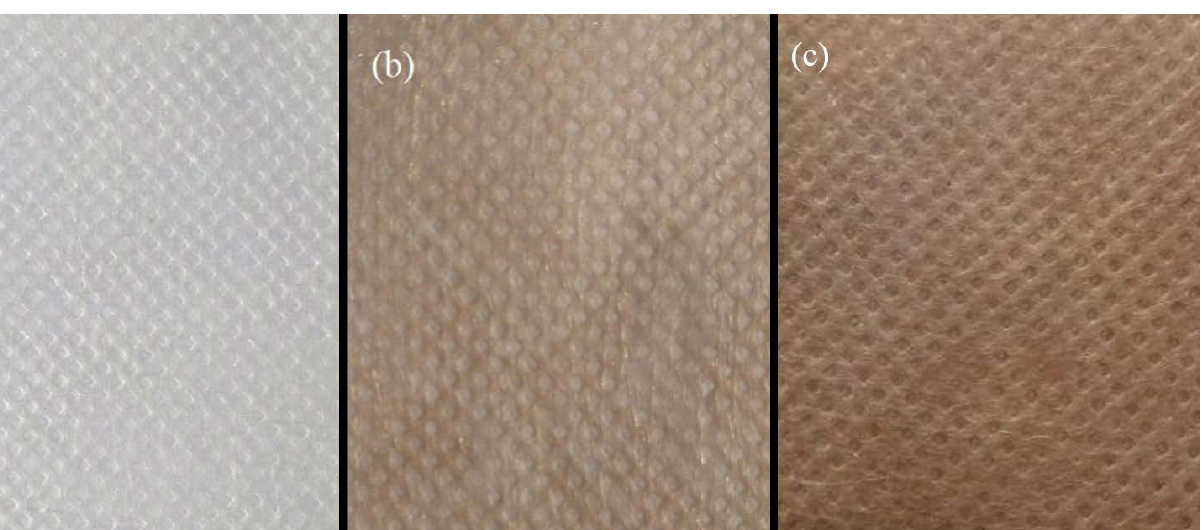
Figure 2. XRD survey scan of PLA nonwoven fabrics: ( a ) control; ( b ) CS-Ag NPs treated; ( c ) DBD- CS-Ag NPs treated. CS-Ag NPs treated.